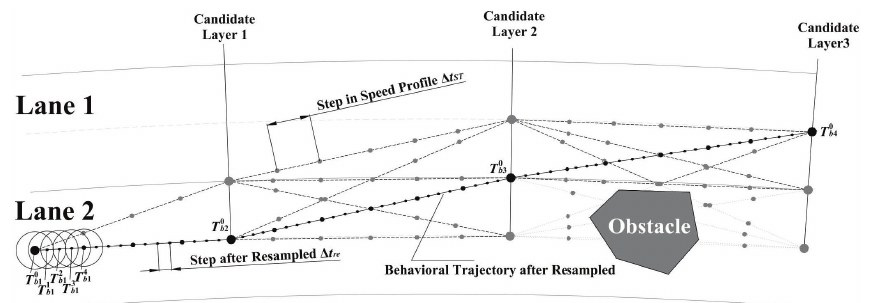
Figure 7. Resampled behavioral